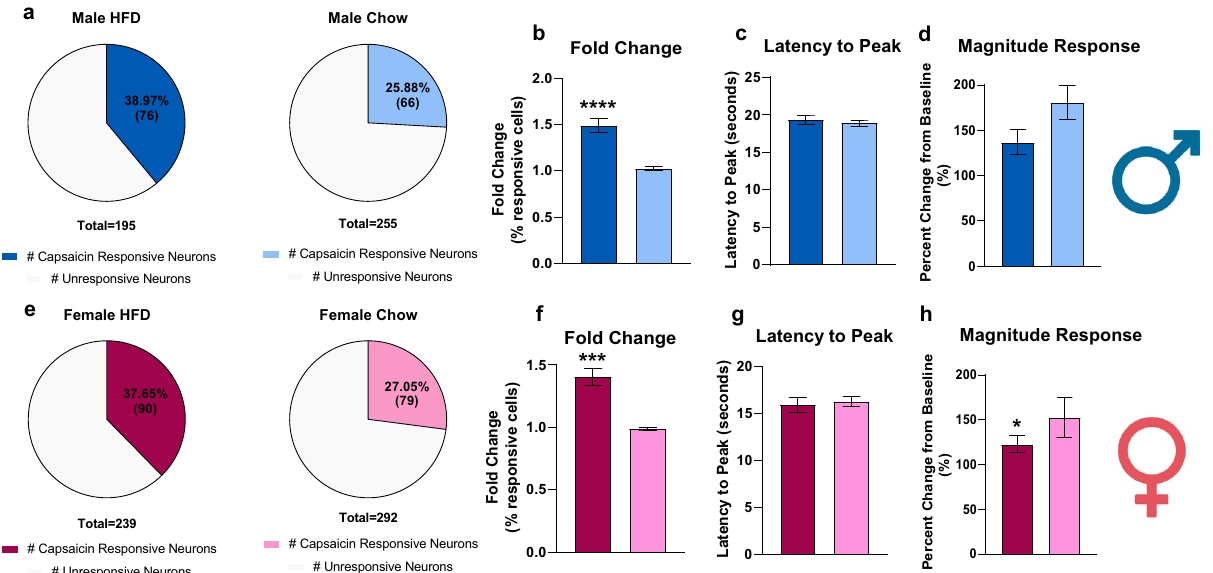
Figure 3. HFD fed males and females have an increased response rate to capsaicin after a short-term HFD regime. ( a , e ) HFD males (n = 6 mice, 195 cells) and females (n = 8 mice, 239 cells) had a significant response (data not shown) rate to capsaicin (males: 38.97% 76 capsaicin-responsive neurons/195 neurons; females: 37.65%, 90 capsaicin-responsive neurons/239 neurons) in comparison to their chow counterparts (males: 25.88%, 66 capsaicin-responsive neurons/255 neurons; females: 27.05%, 79 capsaicin-responsive neurons/292 neurons) (Chow males: n = 9 mice, 255 cells; Chow females: n = 7 mice, 292 cells). ( b , f ) HFD males and females had a significant difference in fold change compared to their chow counterparts. ***p < 0.001; ****p < 0.0001 (Two-way ANOVA with Sidak’s post hoc comparison). ( c , g ) There was no significant diet-dependent effect on the latency to maximum capsaicin response, but ( d , h ) there was a significant diet-dependent effect on response magnitude. *p < 0.05 (Two-way ANOVA with Sidak’s post hoc